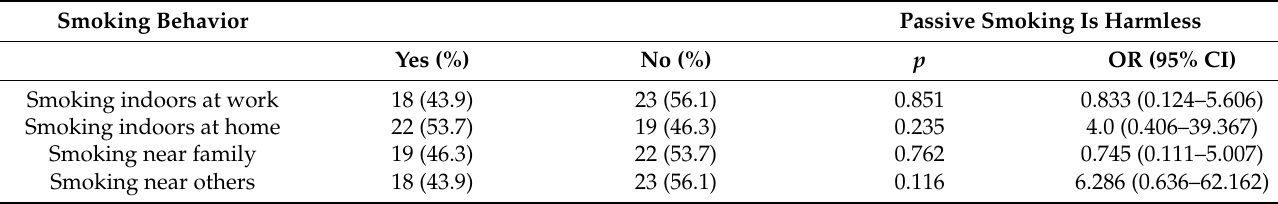
Table 3. Smoking behavior among the 41 smokers (14 students, 27 adults).